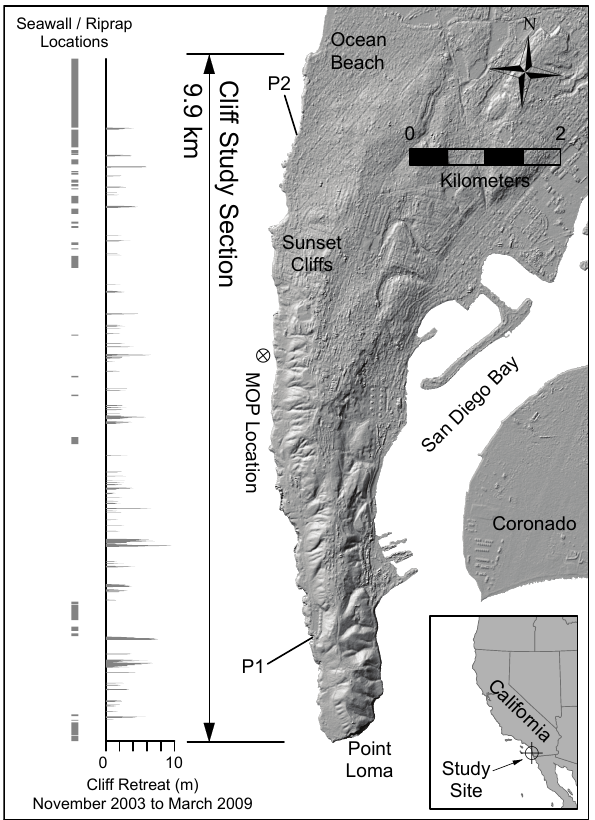
Fig. 1. Location map of the Sunset Cliffs to Point Loma study area showing alongshore projected locations of seawall/riprap and the cumulative cliff retreat (unprotected cliffs) occurring during the study period (October 2003 to March 2009). At least two locations (P1 and P2) with seawall/riprap experienced significant